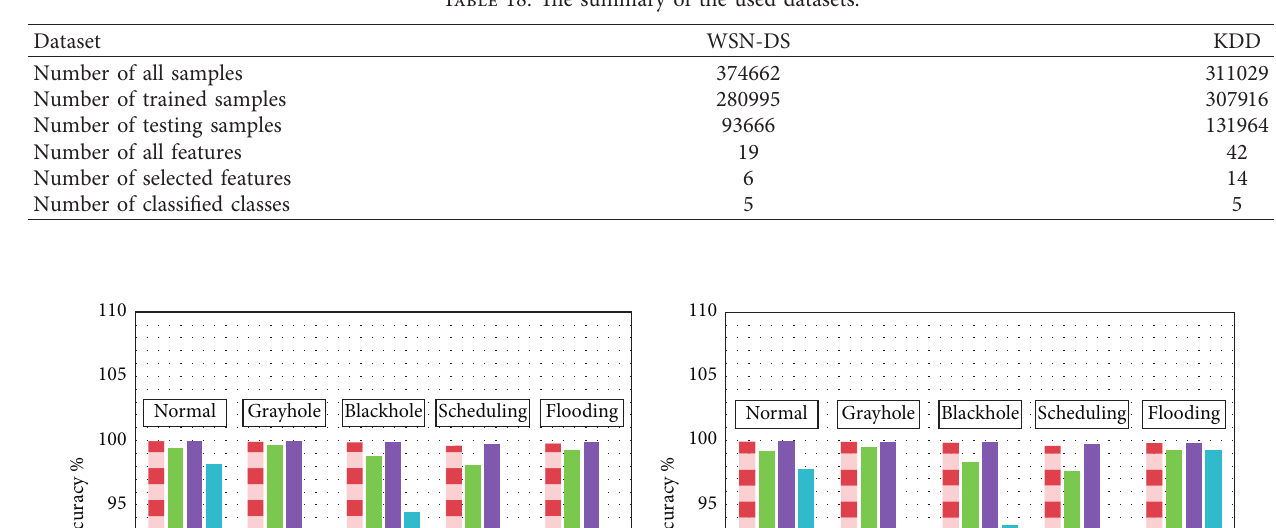
Table 18: The summary of the used datasets.